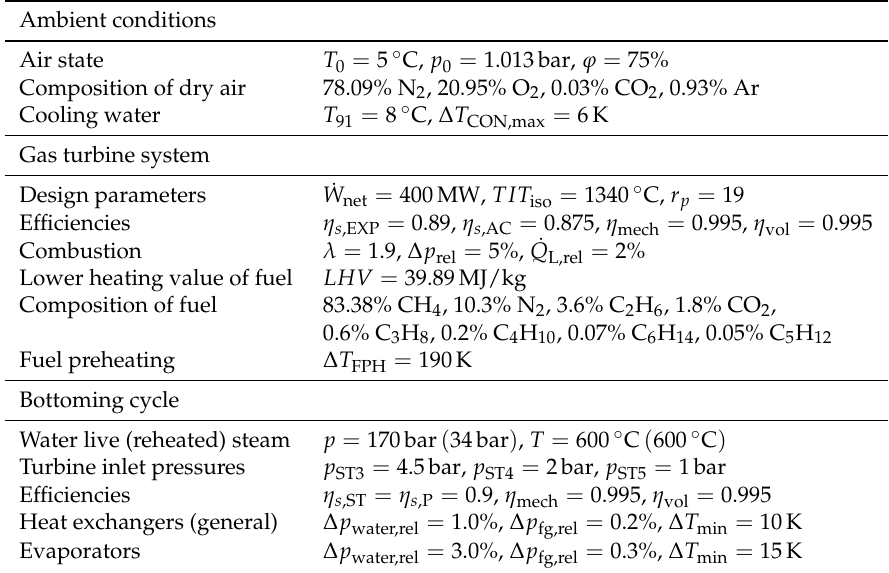
Table 1. Assumptions and given